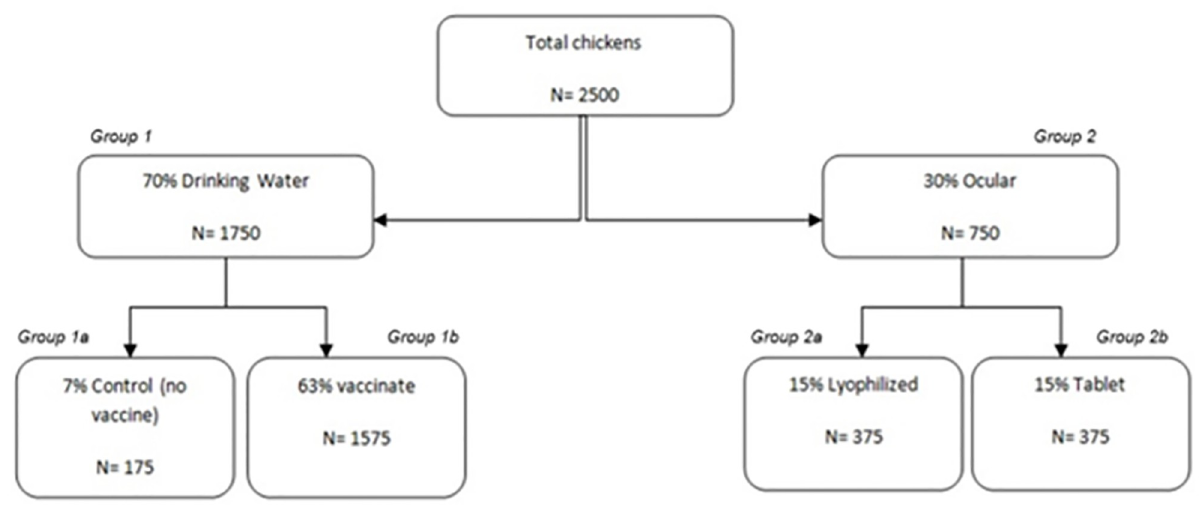
Fig 3. Field trial of Ranigoldunga ™ vaccine in two farms of the Kathmandu Valley. Out of total 2500 chickens vaccination, 7% (n = 175) was selected as control group and 63% (n = 1575) as test group in drinking water and 15%, (n = 375) as test group for ocular administration and 15% (n = 375) test group for tablet formulation and assessed for the vaccine